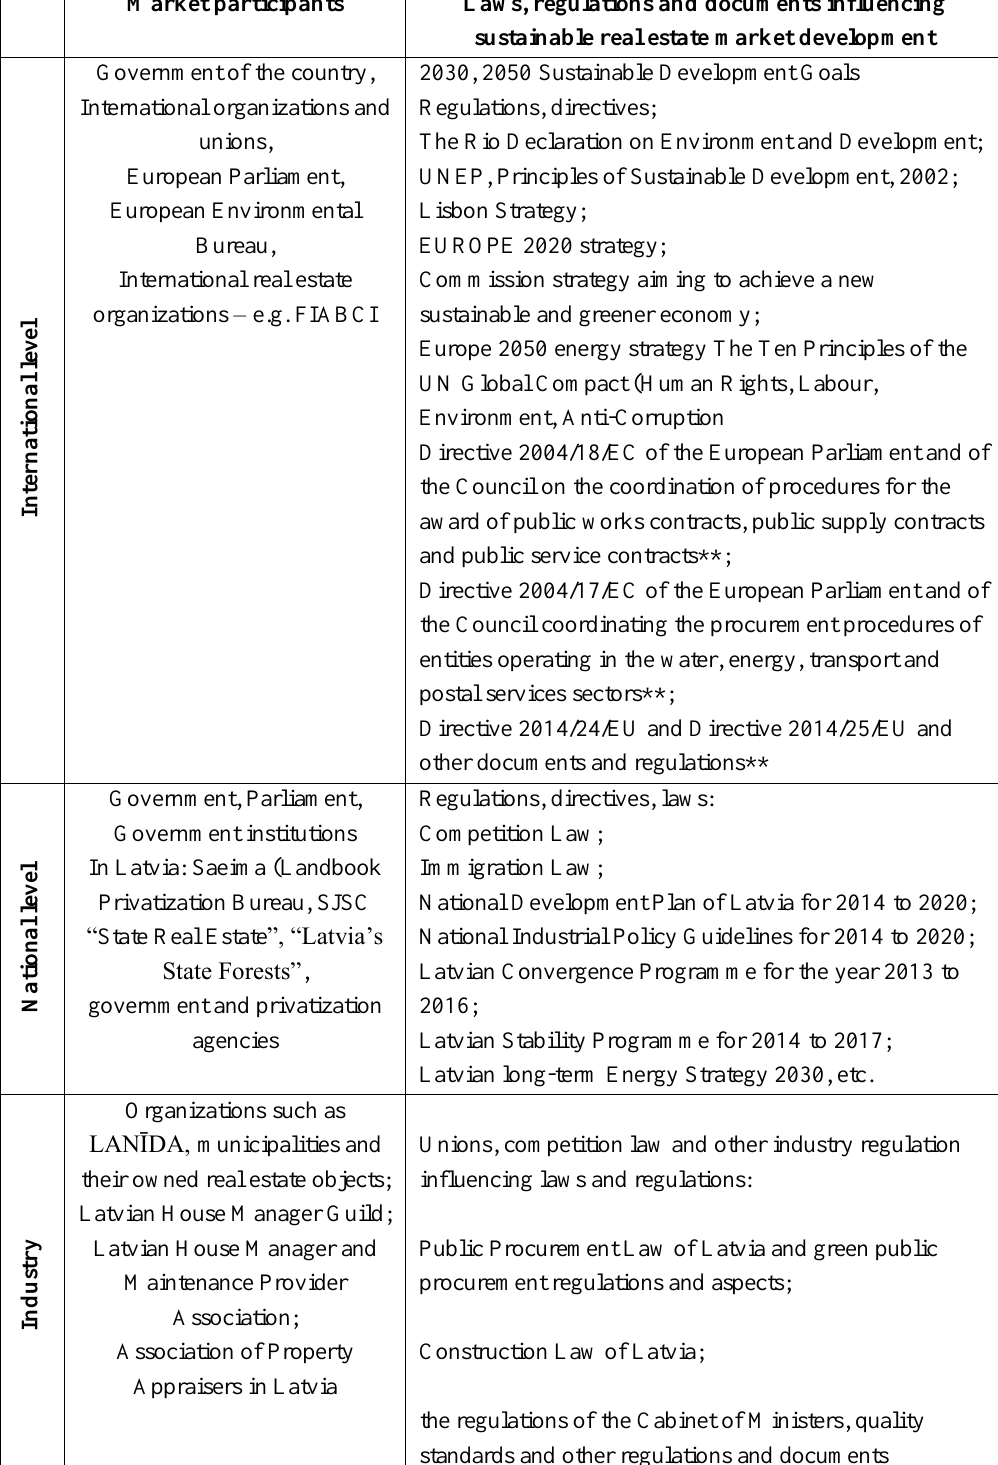
Table 2. Main sustainable real estate market development influencing regulations and key participants by levels in Latvia [developed by authors] Market